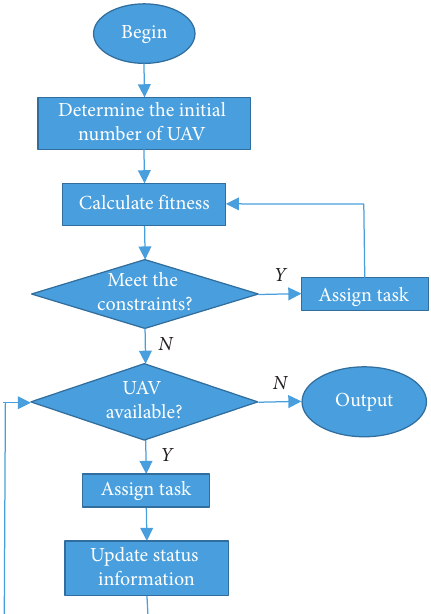
Figure 3: Flow chart of the first task